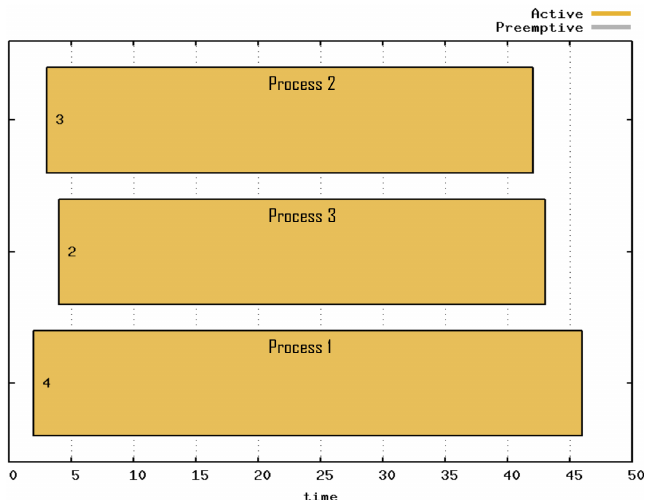
Figure 8. Gantt chart of Priority Scheduling with three processes active throughout the experiment.